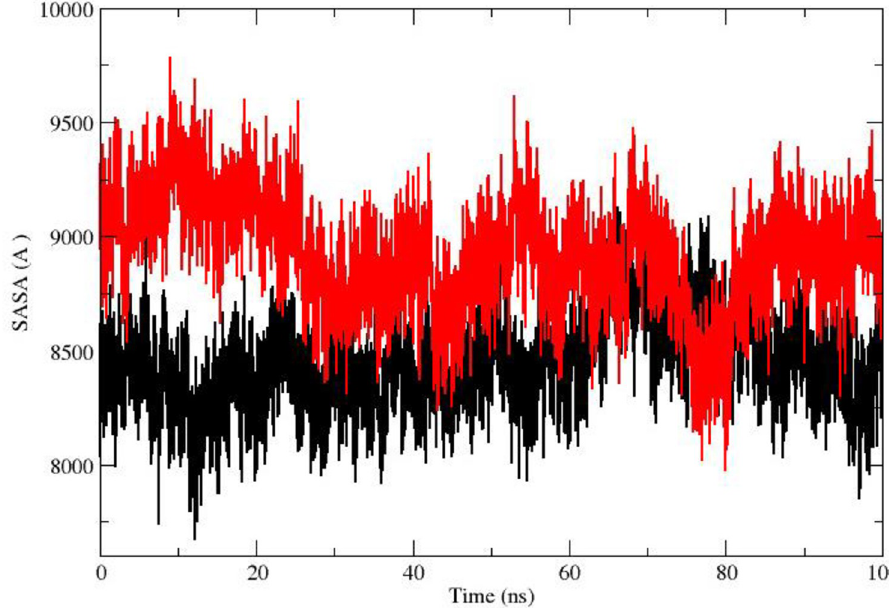
Fig 5. SASA of active phytoconstituents in complex with 1R9W: Black color is indicating clicoemodin and red color indicates stigmasterol.